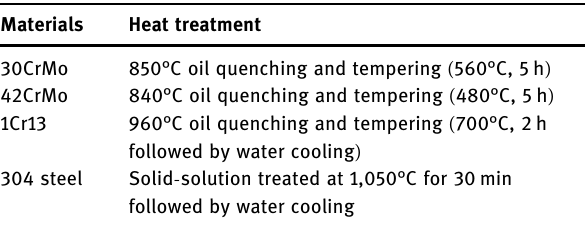
Table 2: Detailed heat treatment conditions for samples